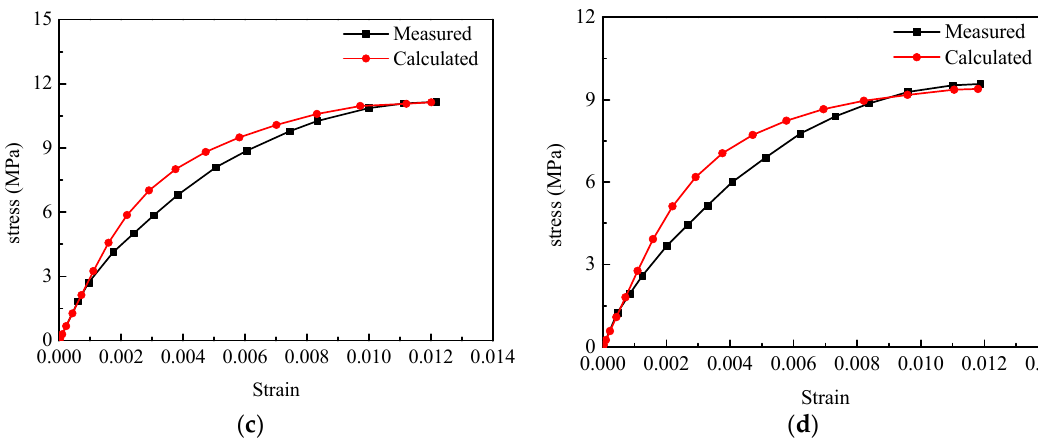
Figure 14. Calculated and measured stress–strain curves for PBX 9501. ( a ) tension; ( b ) compressive strain rate of 10 − 4 s − 1 ; ( c ) compressive strain rate of 10 − 3 s − 1 ; ( d ) compressive strain rate of 10 − 2 s − 1 .